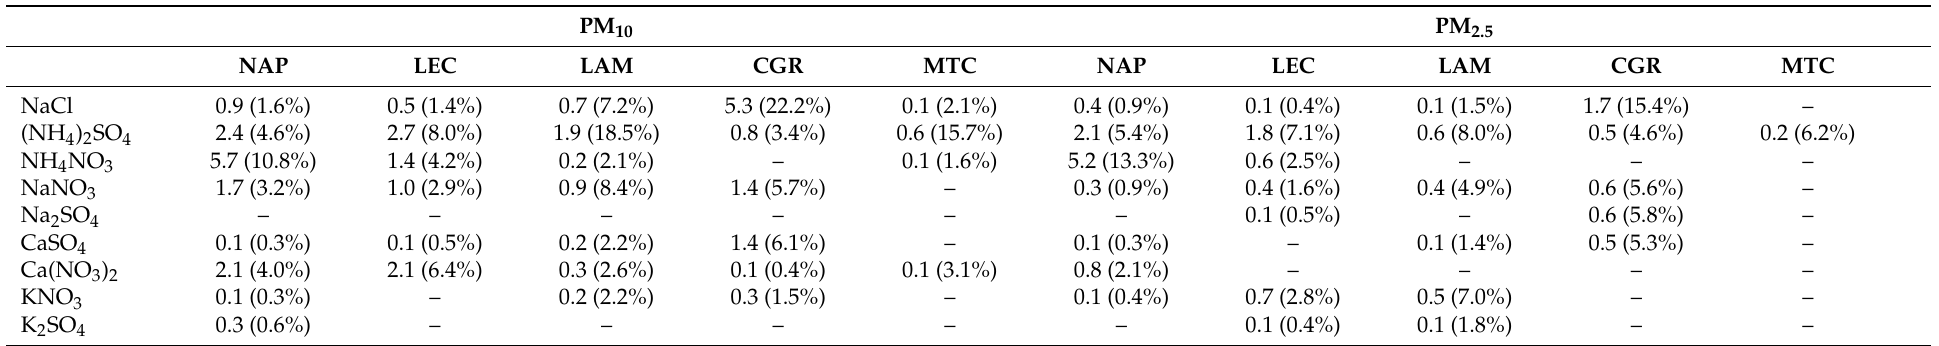
Table 3. Ionic balance for NaCl, (NH 4 ) 2 SO 4 and NH 4 NO 3 and an estimation of other sulfate and nitrate phases. The values are reported as µ g/m 3 and the percentages concerning the total PM masses are in